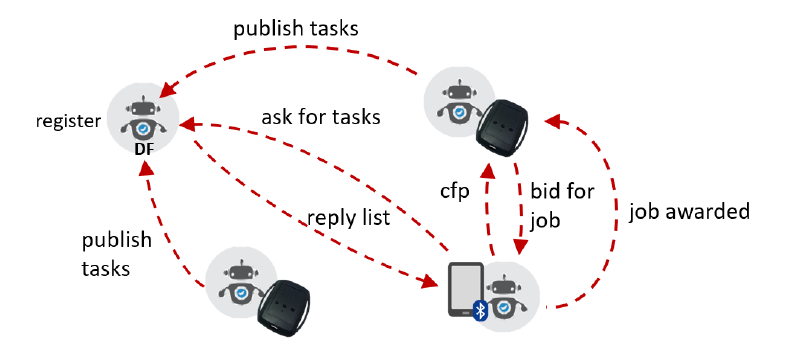
Figure 5. Call-for-proposal interaction among stream processing agents. This interaction can be represented as a FIPA call-for proposals, in which sensor agents publish the tasks they can provide (e.g., sensing and monitoring) in a register agent. Then an application agent can request for agents who are capable of a certain tasks, and emit a cfp. After a bid is performed, the task can be sscheduled and